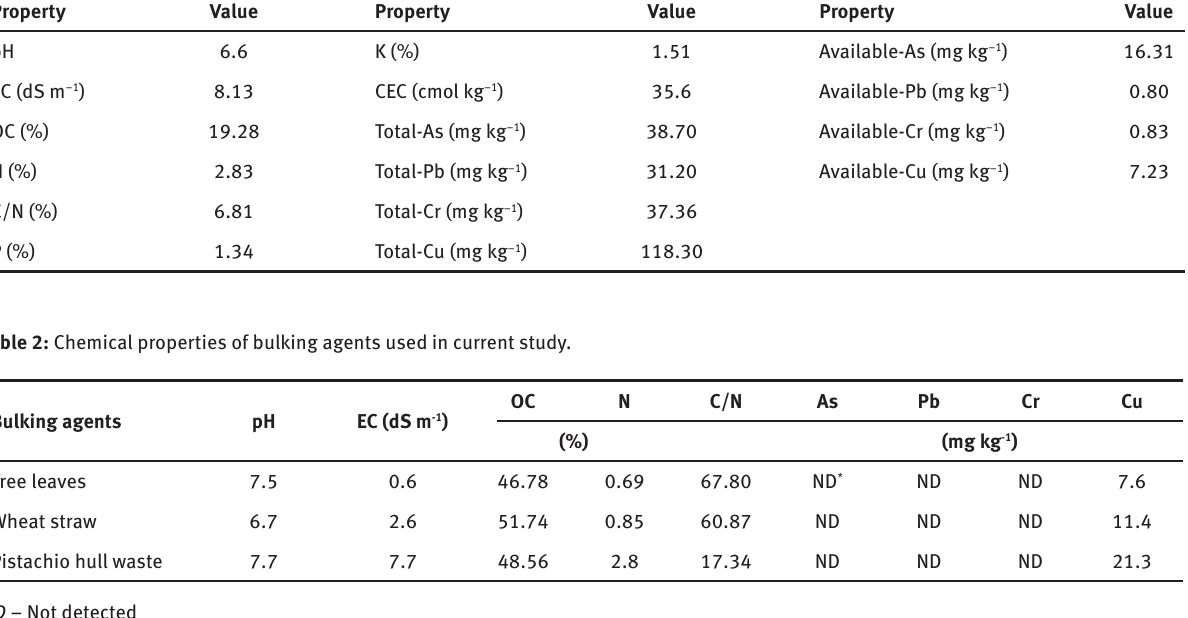
Table 1: Some chemical properties of sewage sludge in this study. Property